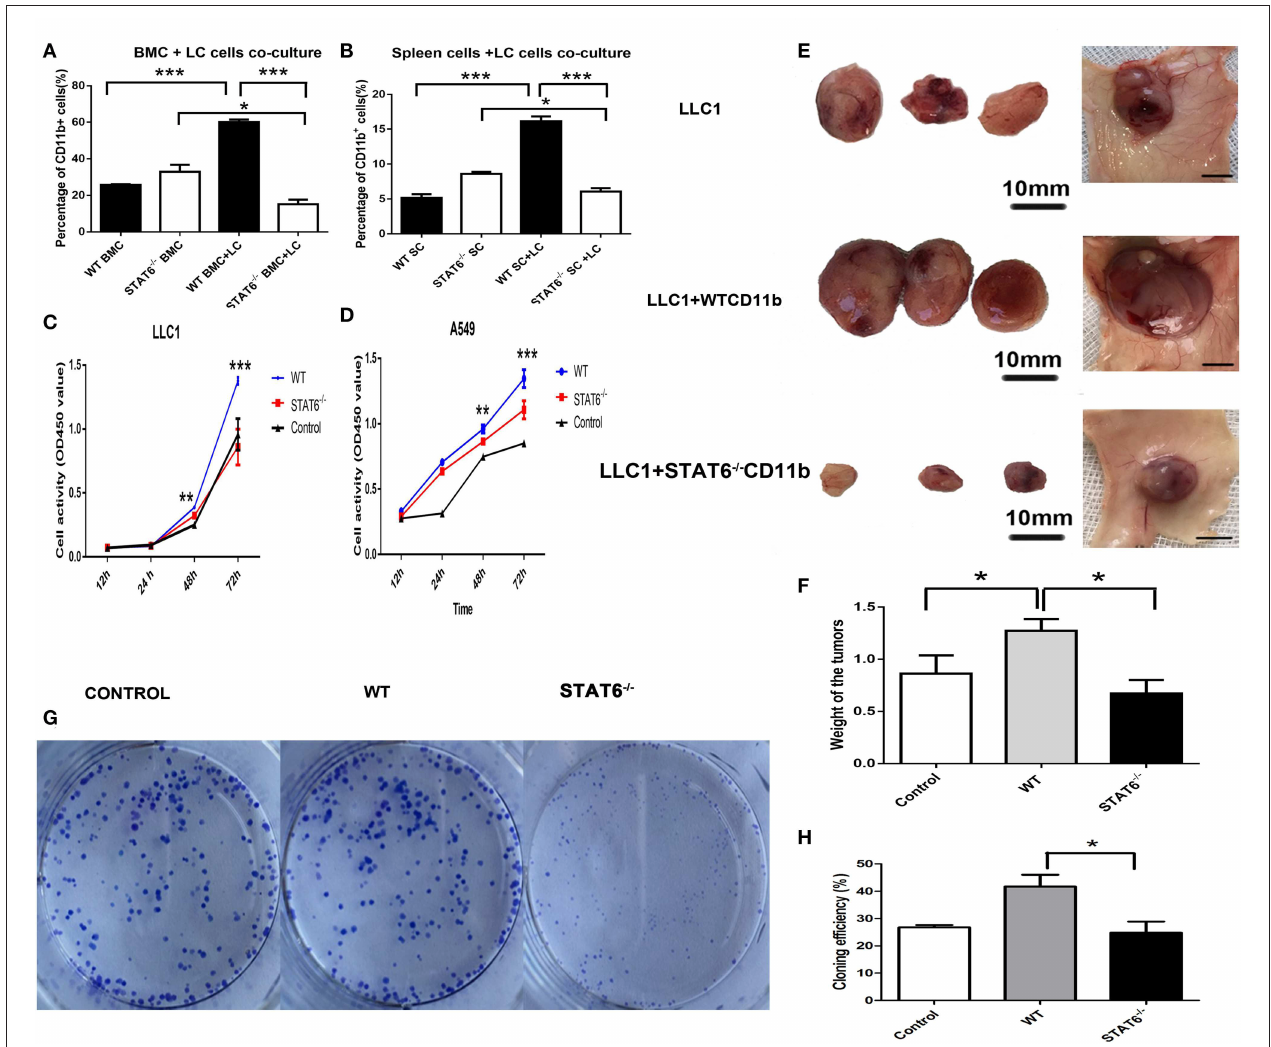
FIGURE 5 | Depletion of signal transducer and activator of transcription 6 (STAT6) in CD11b + cell affects tumor growth. (A,B) Lung cancer cells (LLC1) were cocultured with either bone marrow cells or spleen cells, and the percentages of CD11b + cells were analyzed by FACS. (A) Percentage of CD11b + cells in bone marrow cells derived from STAT6 − / − mice or WT littermates when cocultured with LLC1 cells. (B) Percentage of CD11b + cells in spleen cells derived from STAT6 − / − mice or WT littermates when cocultured with LLC1 cells. (C,D) Proliferation curve of LLC1/A549 cells when cocultured with CD11b + cells derived from mice. WT group indicates coculture of cancer cells with CD11b + cells derived from WT mice; STAT6 − / − group indicates coculture of cancer cells with the same number of CD11b + cells derived from STAT6 − / − mice as in the WT group; equal numbers of cancer cells were substituted for CD11b + cells in the control group. (E) Facade of tumor volume in the control, WT, and STAT6 − / − groups. An equal number of CD11b + cells (1 × 10 6 ) derived either from STAT6 − / − mice or WT mice was mixed with 1 × 10 6 LLC1 cells and inoculated subcutaneously into nude mice. An equal number of LLC1 cells (1 × 10 6 ) was substituted for the CD11b + cells in the control group. After 10 weeks, tumor sizes and weights were measured. (F) Tumor weights in the control, WT, and STAT6 − / − groups. (G,H) Colony formation of cancer cells (CMT167) cocultured with CD11b + cells derived from either STAT6 − / − mice or WT littermates 7 days after the start of the experiment. The control group shows the colony formation of cancer cells cocultured with the same number of cancer cells as CD11b + cells. * P < 0.05, ** P < 0.01, *** P <